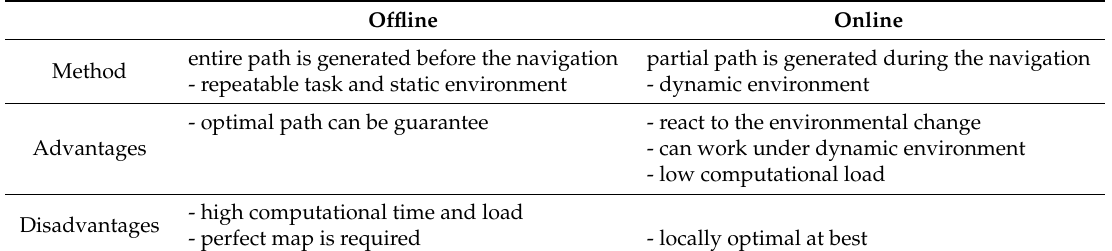
Table 1. Comparison between online path planning and offline path